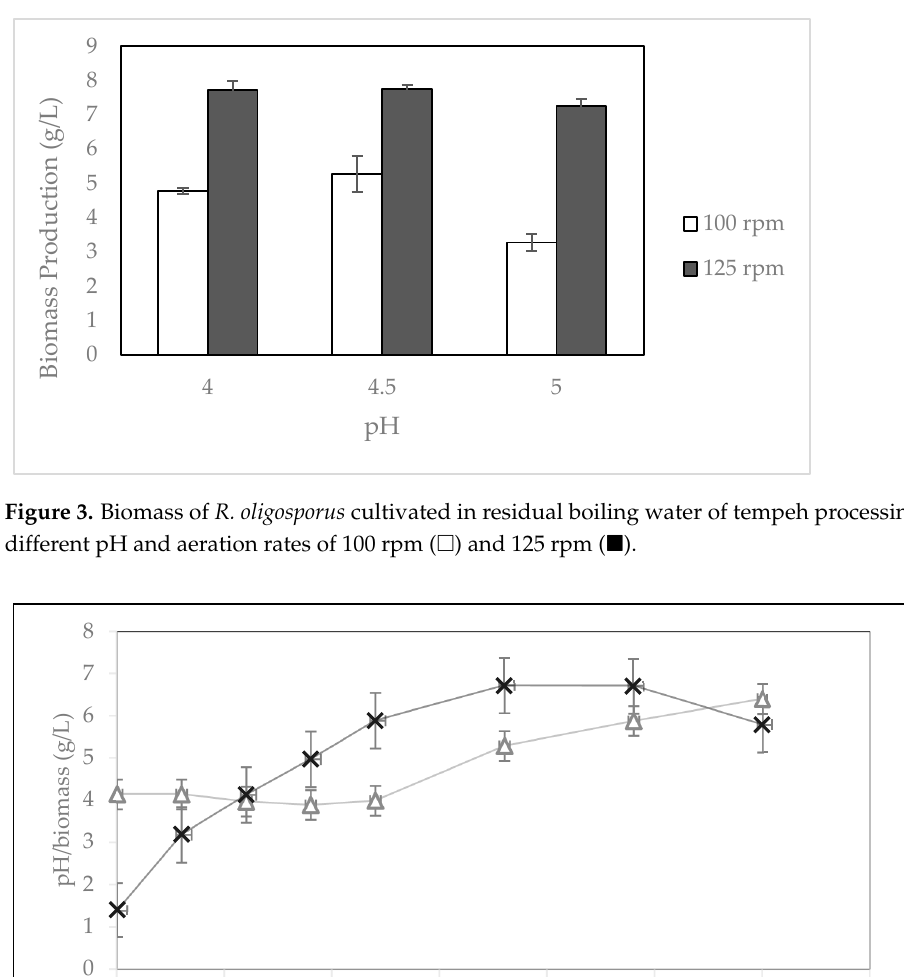
Figure 3. Biomass of R. oligosporus cultivated in residual boiling water of tempeh processing under di ff erent pH and aeration rates of 100 rpm ( □ ) and 125 rpm ( ■ ).